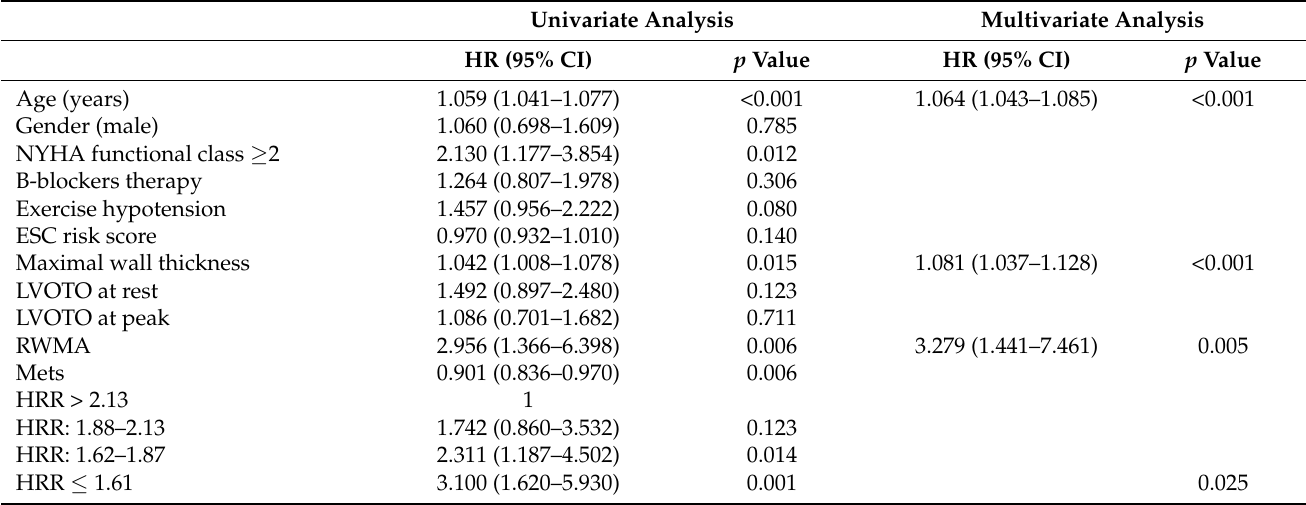
Table 4. Univariate and multivariate predictors of all-cause death. Univariate Analysis Multivariate Analysis